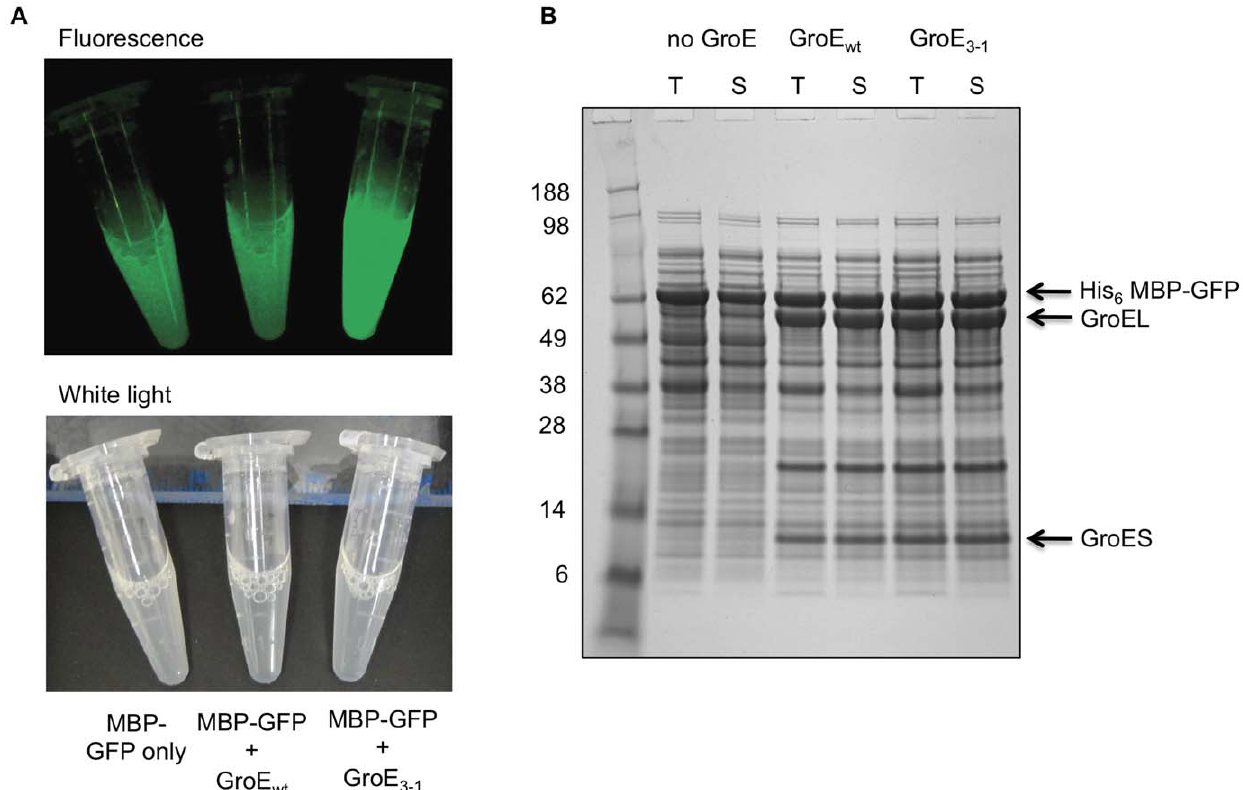
Figure 4. Interaction of MBP fusion proteins with GroEL/S. ( A ) Lysed cells co-expressing H 6 -MBP-GFP and either wild-type GroE or the GroE 3–1 variant are shown under blue or white light illumination. Cells co-expressing GroE 3–1 fluoresce more intensely than cells co-expressing wild-type GroE as a result of enhanced GFP folding. Cells expressing only the MBP-GFP fusion protein are shown on the left. ( B ) SDS-PAGE analysis of total and soluble proteins from the cells in (A). T, total intracellular protein; S, soluble intracellular protein.